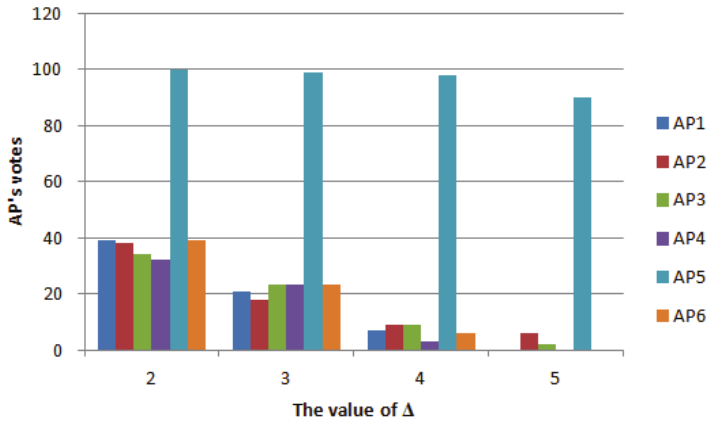
Figure 8. Voting